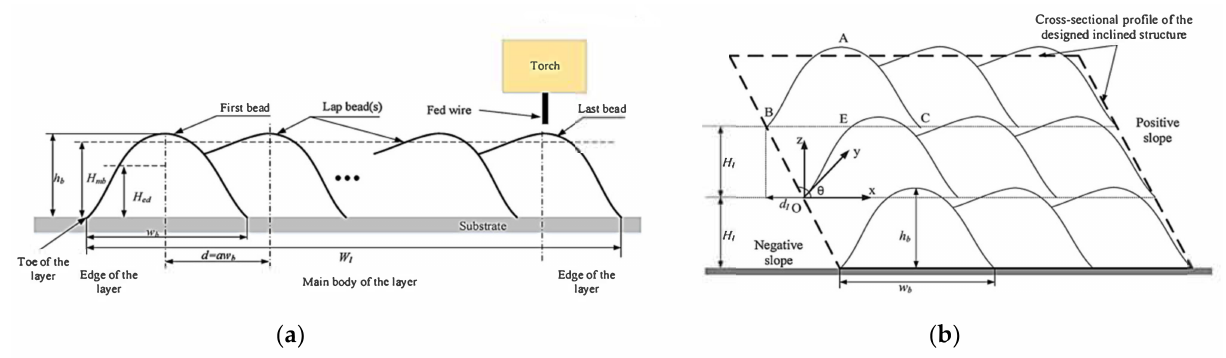
Figure 40. Geometric model of the cross-section profile of inclined MLMB structure: ( a ) base model; ( b ) geometrical model. Reprinted with permission from Ref. [82]. Copyright 2018 Elsevier.